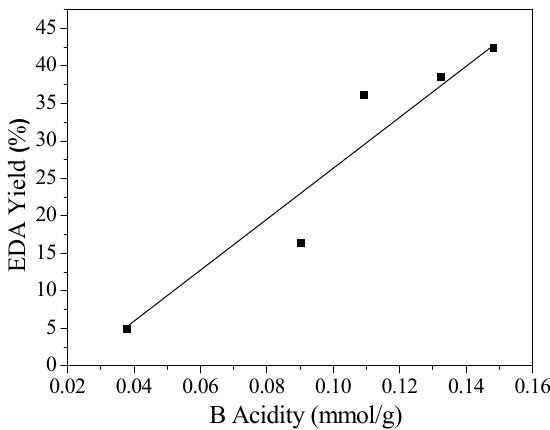
Figure 6. Relationship between B acid amount and EDA yield of the samples before and after alkali treatment. Reaction conditions: temperature = 310 °C, pressure = 4.0 MPa, NH 3 /MEA (mol/mol) = 21/1, LHSV = 4.58 h − 1 .